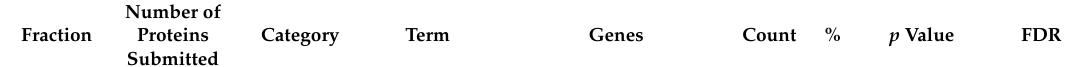
Table 1. The most altered pathways identified by the DAVID enrichment analyses performed on the proteins dysregulated in the skeletal muscle (SF and MF) of male C26